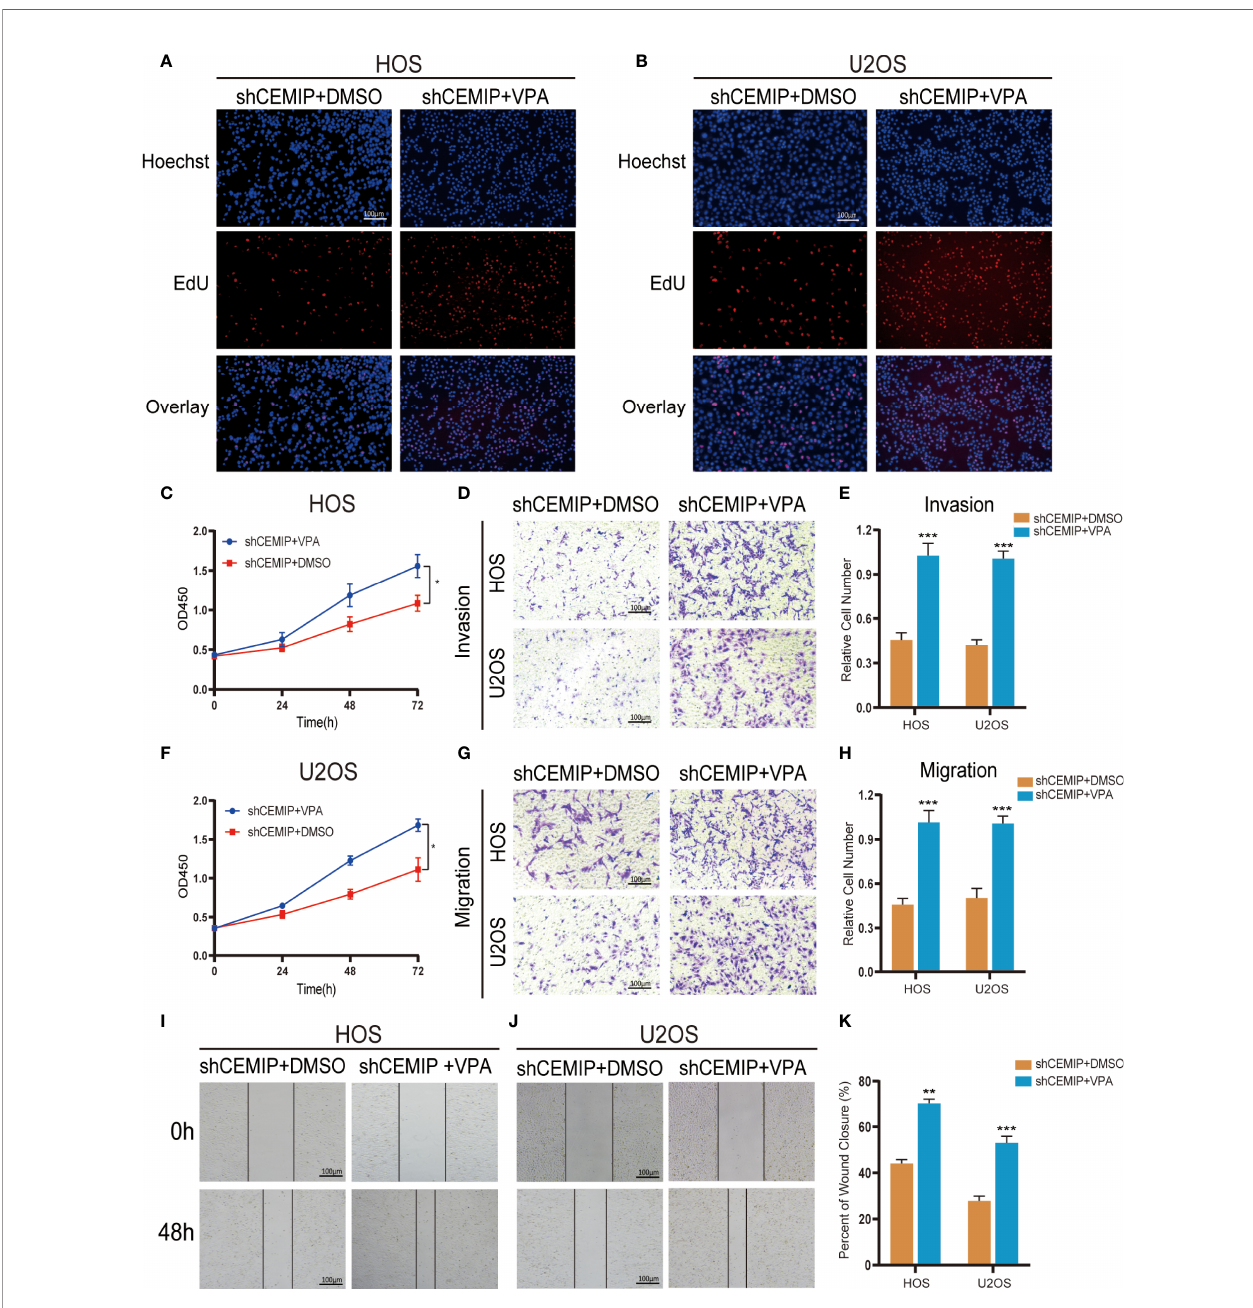
FIGURE 7 | Activation of Notch signaling pathway reverses growth, invasion and migration of osteosarcoma cells caused by siliencing CEMIP. (A, B) The effect of VPA on growth of shCEMIP osteosarcoma cells were measured by EdU assays. (C, F) The effect of VPA on growth of shCEMIP osteosarcoma cells were measured by CCK-8 assays. (D, E) The effect of VPA on invasion of shCEMIP osteosarcoma cells were analyzed by transwell invasion assays and their quantitative analysis. (G, H) The effect of VPA on migration of shCEMIP osteosarcoma cells were analyzed by transwell migration assays and their quantitative analysis. (I – K) The effect of VPA on migration capacity of shCEMIP osteosarcoma cells were detected by wound healing assays and its quantitative analysis. * P < 0.05, ** P < 0.01, *** P <